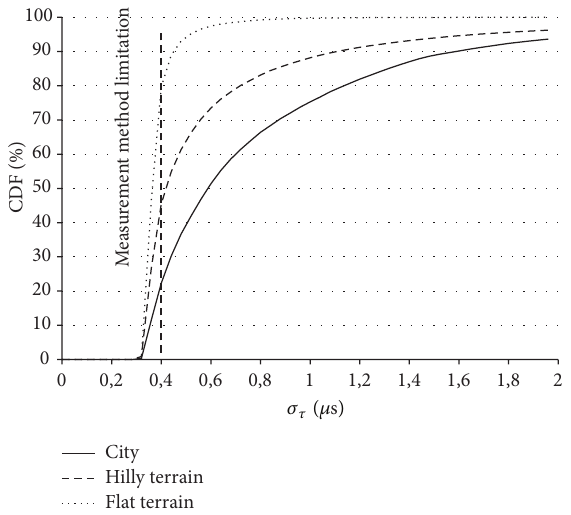
Figure 8: Cumulative distribution function of rms delay spread in three environments.